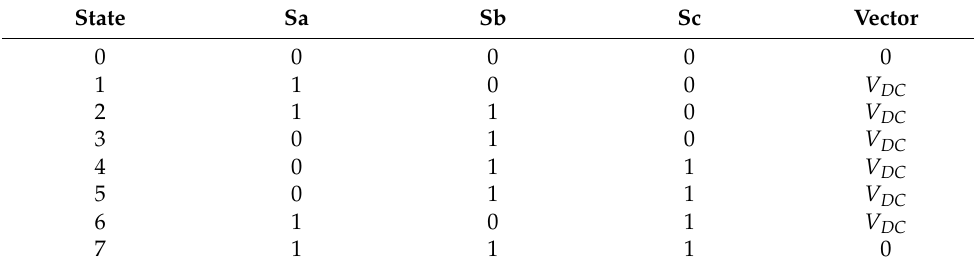
Table 1. Operating and switching states.